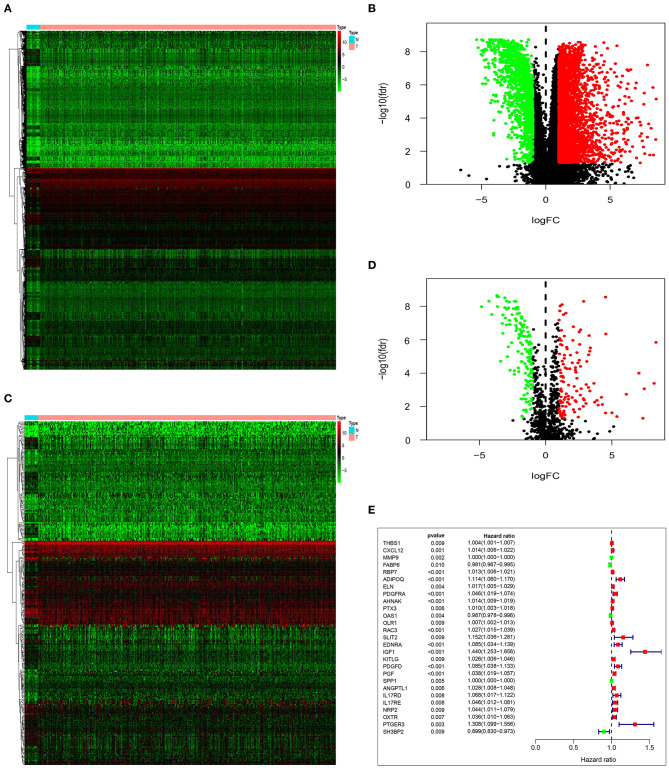
Identification of prognostic immune-related DEG. Heatmap (A) and volcano plot (B) demonstrating DEG between normal bladder tissues and urothelial carcinoma tissues. Heatmap (C) and volcano plot (D) indicating immune-related DEG. (E) Forest plot of hazard ratios and P-value showing the prognostic values of 27 immune-related DEG in univariate Cox proportional hazards regression analysis.